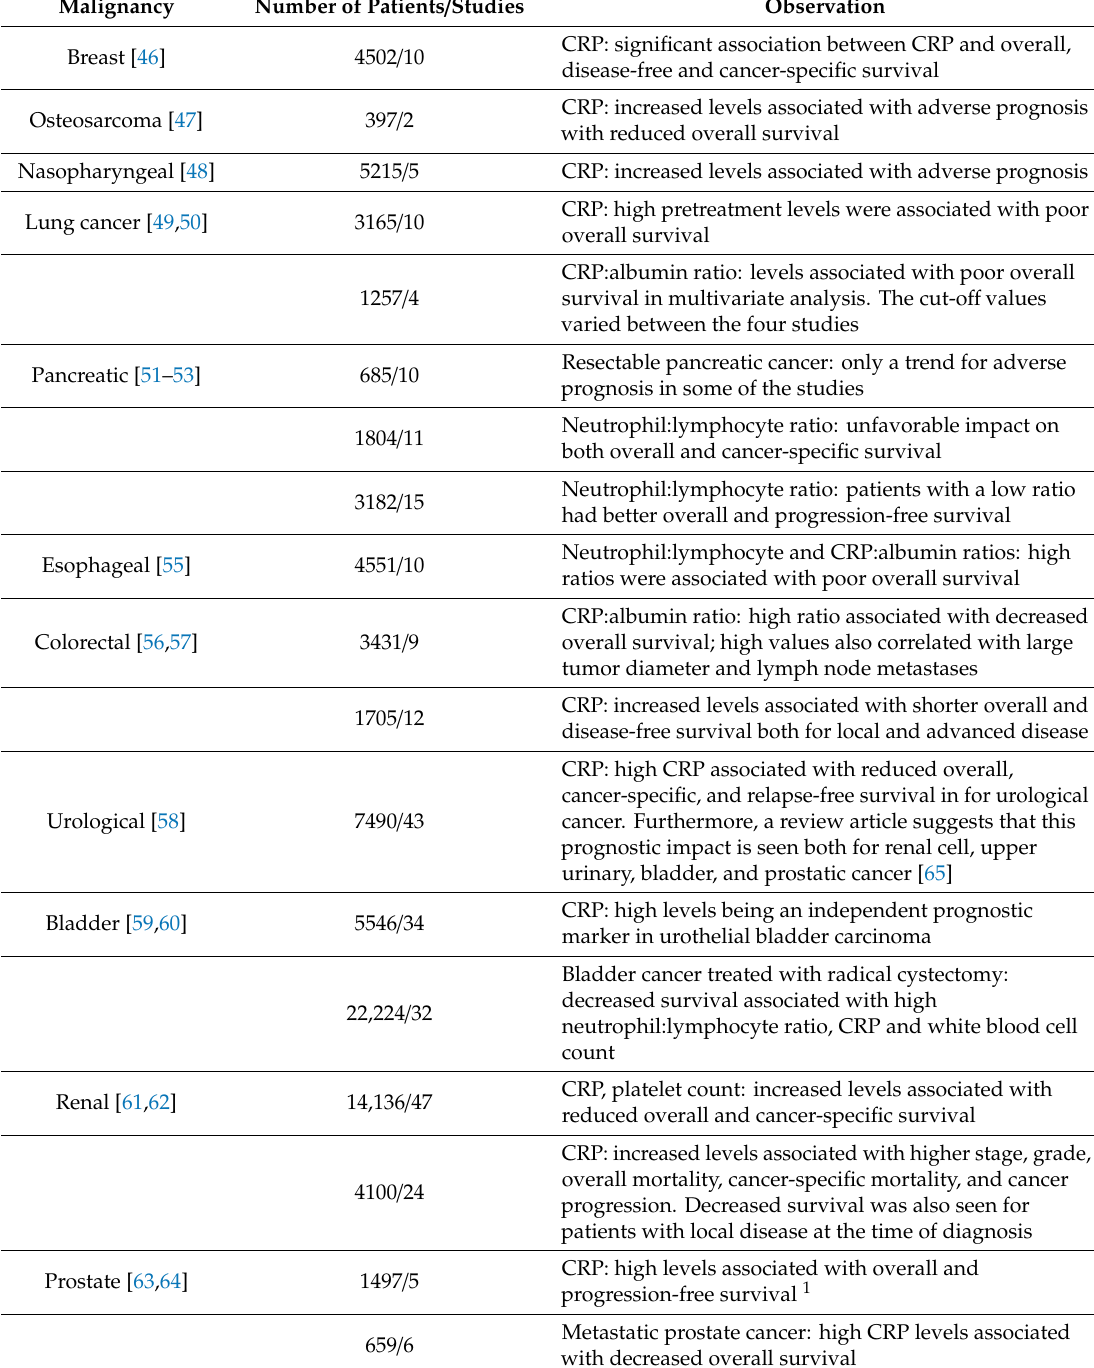
Table 4. The prognostic impact of inflammatory mediators in cancer; a summary of the results from systematic reviews and meta-analyses [46–64] 1